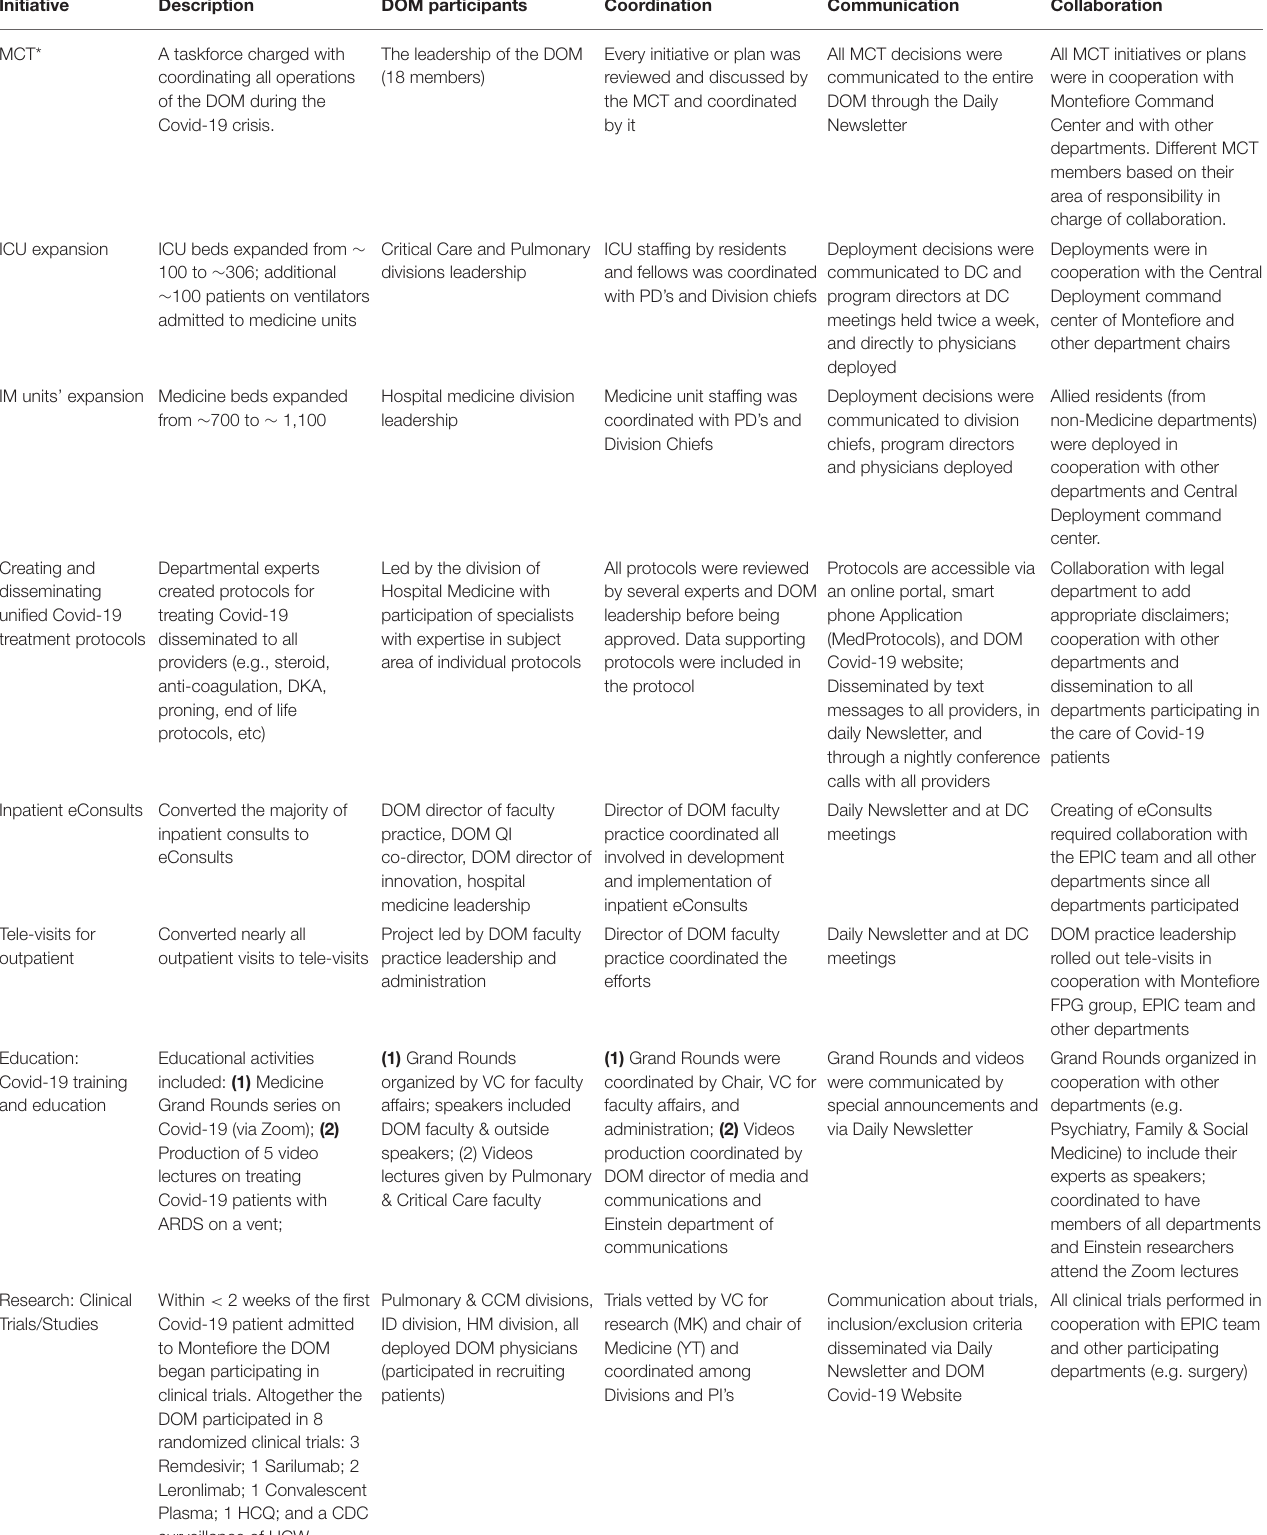
TABLE 1 | List of Department of Medicine (DOM)-led initiatives in which the 3C framework was implemented.